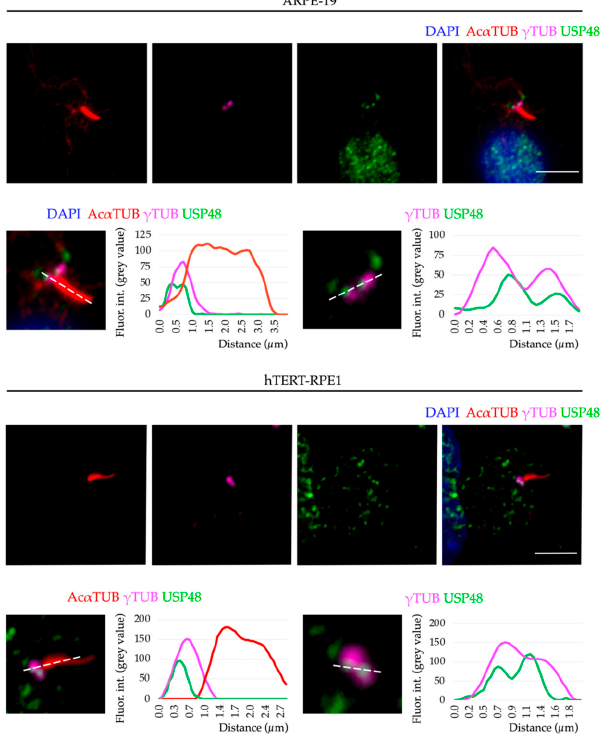
Figure 2. Endogenous USP48 localises to the basal body in ciliated human retinal pigment epithelium cells. Serum-starved ARPE-19 cells (upper panels) and hTERT-RPE1 cells (lower panels) were immunostained with anti-acetylated α -tubulin (Ac α TUB, red) to highlight the ciliary axoneme, anti- γ -tubulin ( γ TUB, magenta) to label the basal body, and anti-USP48 (green). Cell nuclei were counterstained with DAPI (blue). Below each panel, high magnification images of the cilium (left) and basal body (right) with their corresponding plot profiles to quantify the distribution of the fluorescence intensity signal along the discontinuous white lines reveal that a pool of the endogenously expressed USP48 colocalises with γ -tubulin in both human cell lines. The images are one single focal plane. Scale bar: 5 µ m. Fluor. int., fluorescence